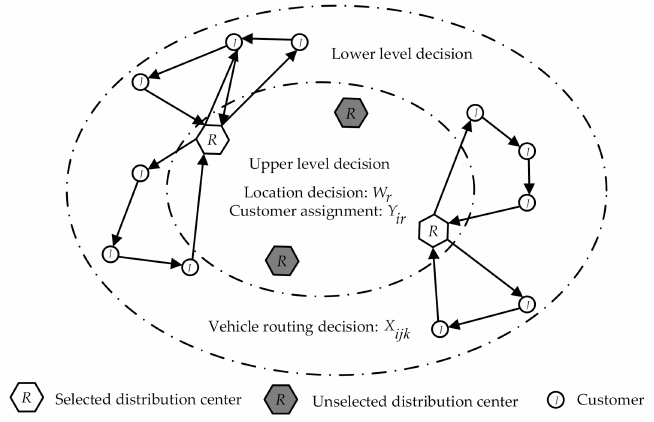
Figure 1. Problem description